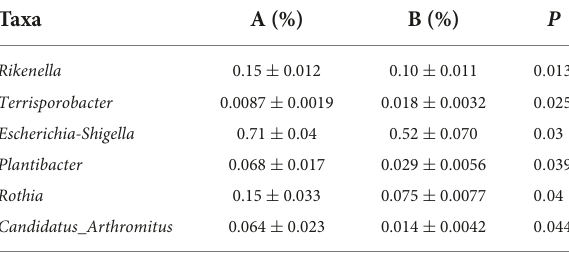
A and B indicated the control and low dose black soldier fly oil treatment groups, respectively.Datawereindicatedasmean ±